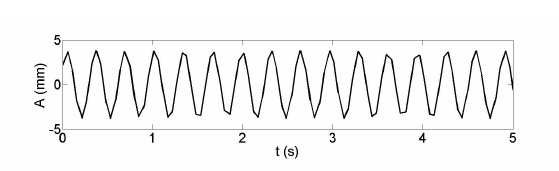
Figure 6a. Thin plate centroid trajectory-10 Hz